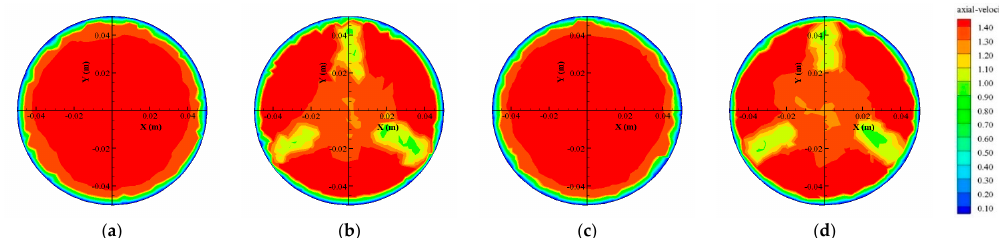
Figure 9. Axial flow velocity distributions of the upstream sections of capsules. ( a ) Z = 0.105 m, L/D = 2; ( b ) Z = 0.075 m, L/D = 2; ( c ) Z = 0.105 m, L/D = 1.67; ( d ) Z = 0.075 m, L/D = 1.67.